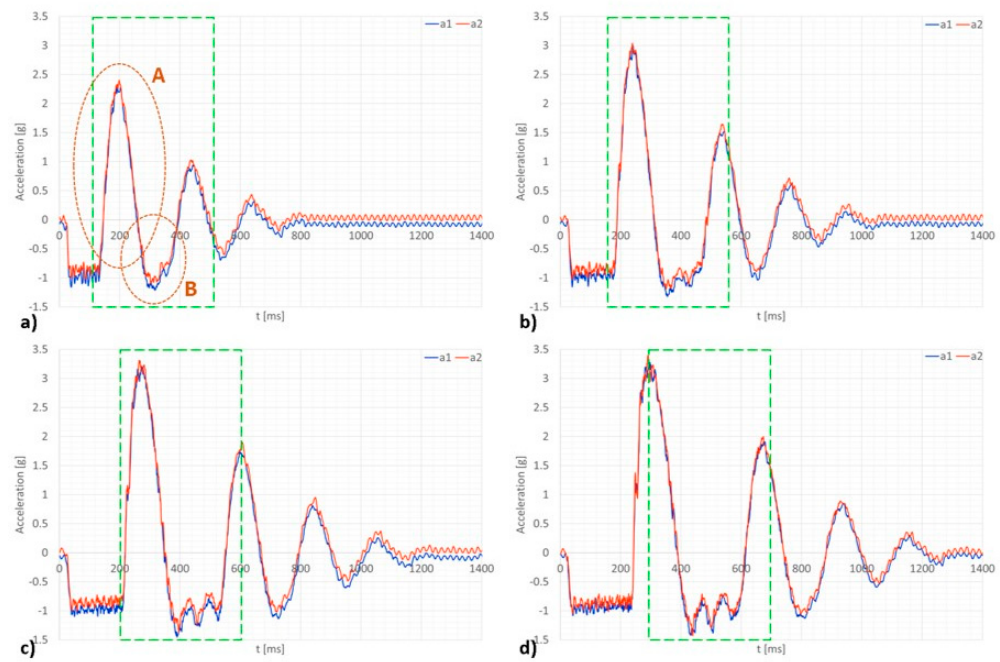
Figure 16. Accelerometer signals recorded at four different heights. ( a ) h = 0.05 m; ( b ) h = 0.10 m; ( c ) h = 0.15 m; and ( d ) h = 0.20 m.